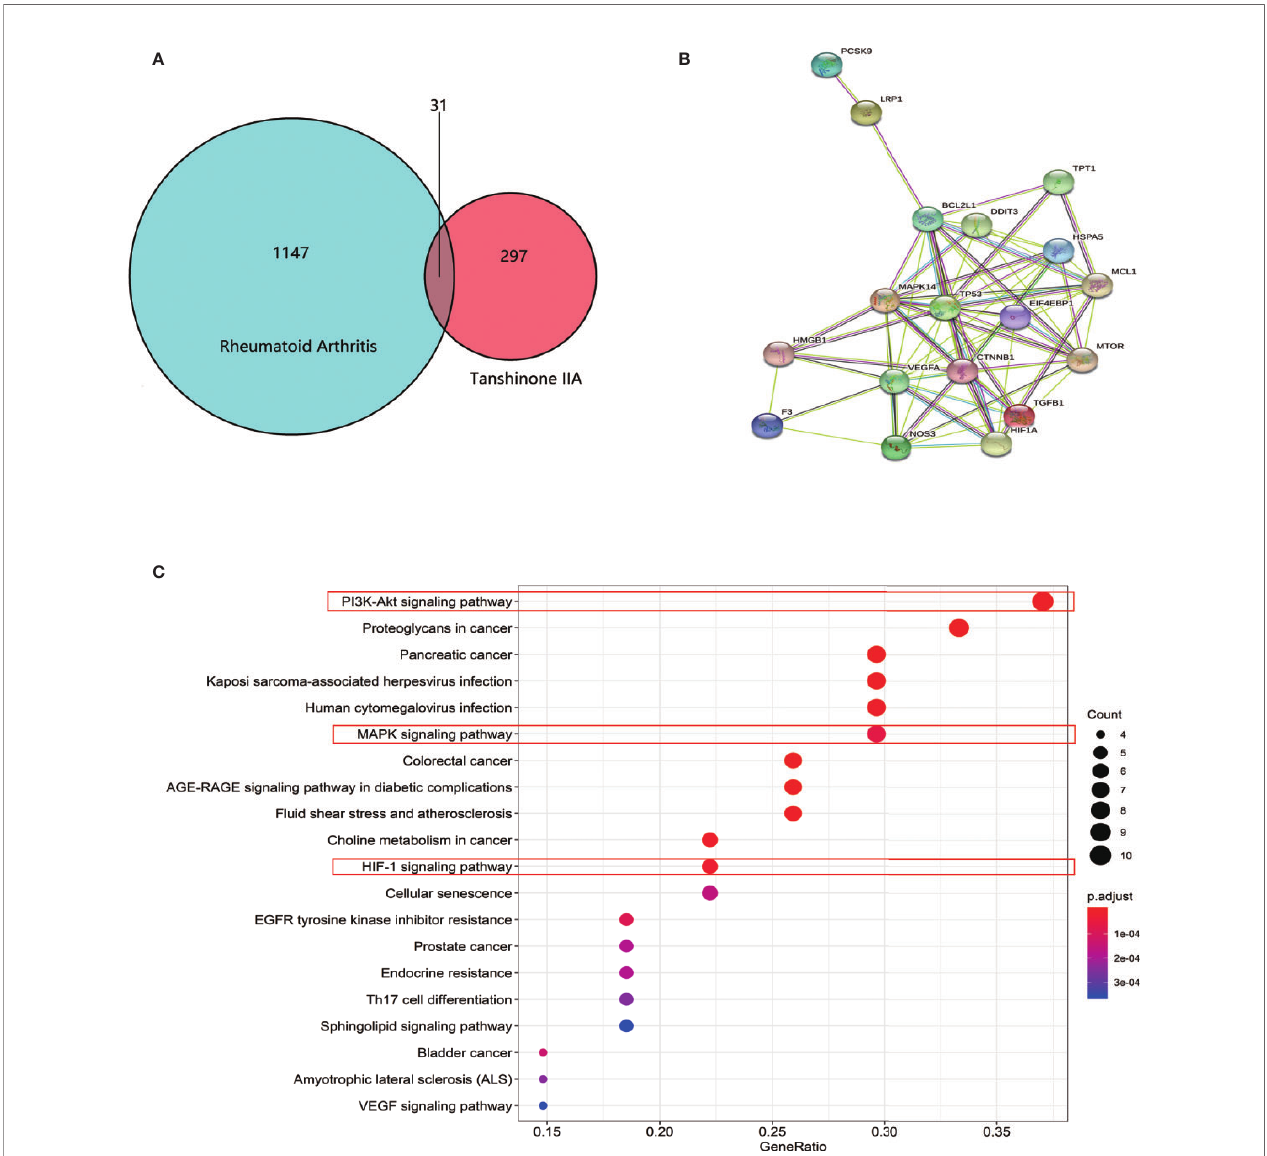
FIGURE 5 | Enrichment analysis of Tan IIA against rheumatoid arthritis: (A) Venn diagram revealing the overlapping target genes of Tan IIA against rheumatoid arthritis. (B) Protein interaction network of the overlapping target genes of Tan IIA against rheumatoid arthritis. Each network node represents all the proteins produced by a single, protein-coding gene locus, and the edge represents protein – protein associations. (C) KEGG enrichment and network analysis of RA target genes. Top 20 functionally enriched biological processes with corresponding adjusted p -values, displayed in a dot plot. The color scale indicates the different thresholds of adjusted p-values, and the sizes of the dots represented the gene count of each